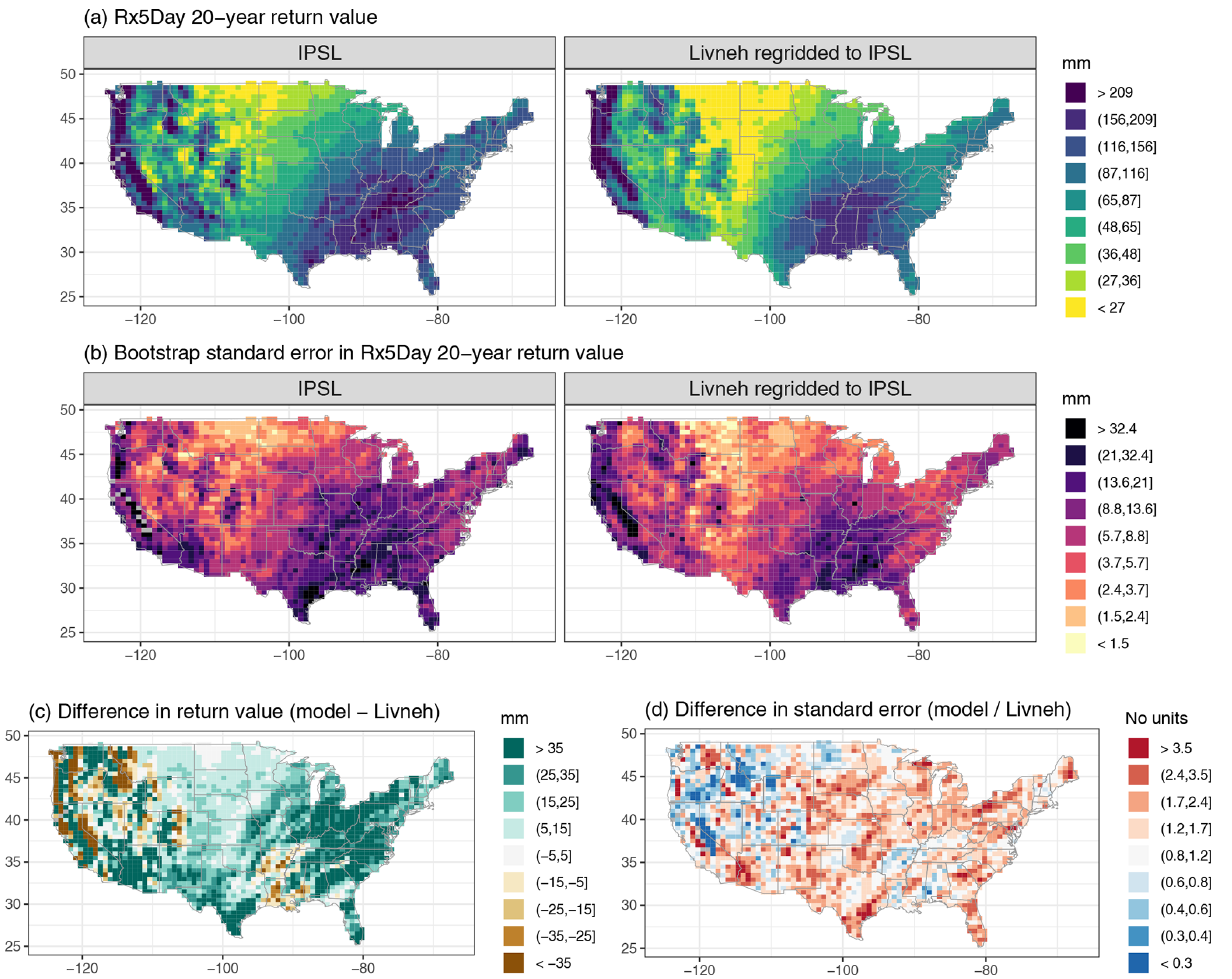
Figure A6. Wintertime (DJF) 20-year return values in Rx5Day (mm) for the IPSL model and regridded L15 (a) , with the bootstrap standard error (mm; b ). Also shown is the difference in return values (model minus regridded L15) as well as the ratio of standard errors (model divided by regridded